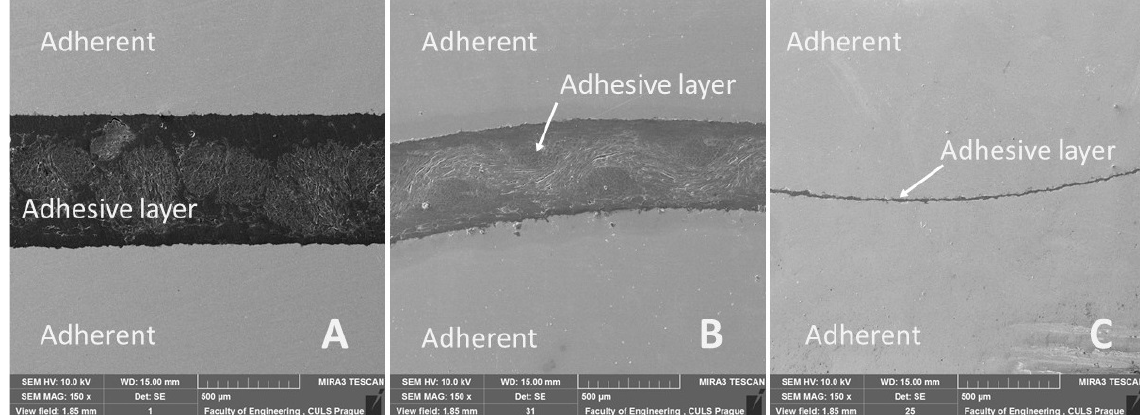
Figure 11. SEM images of samples cut through the adhesive bond: ( A ): cut through Tera-Flat, 0 cycles (MAG 150×), ( B ): cut through Erik-WH1, 1000 cycles in interval 5–50% (267–2674 N) (MAG 150×), ( C ): cut through Resin-WH2, 0 cycles (MAG 150×).